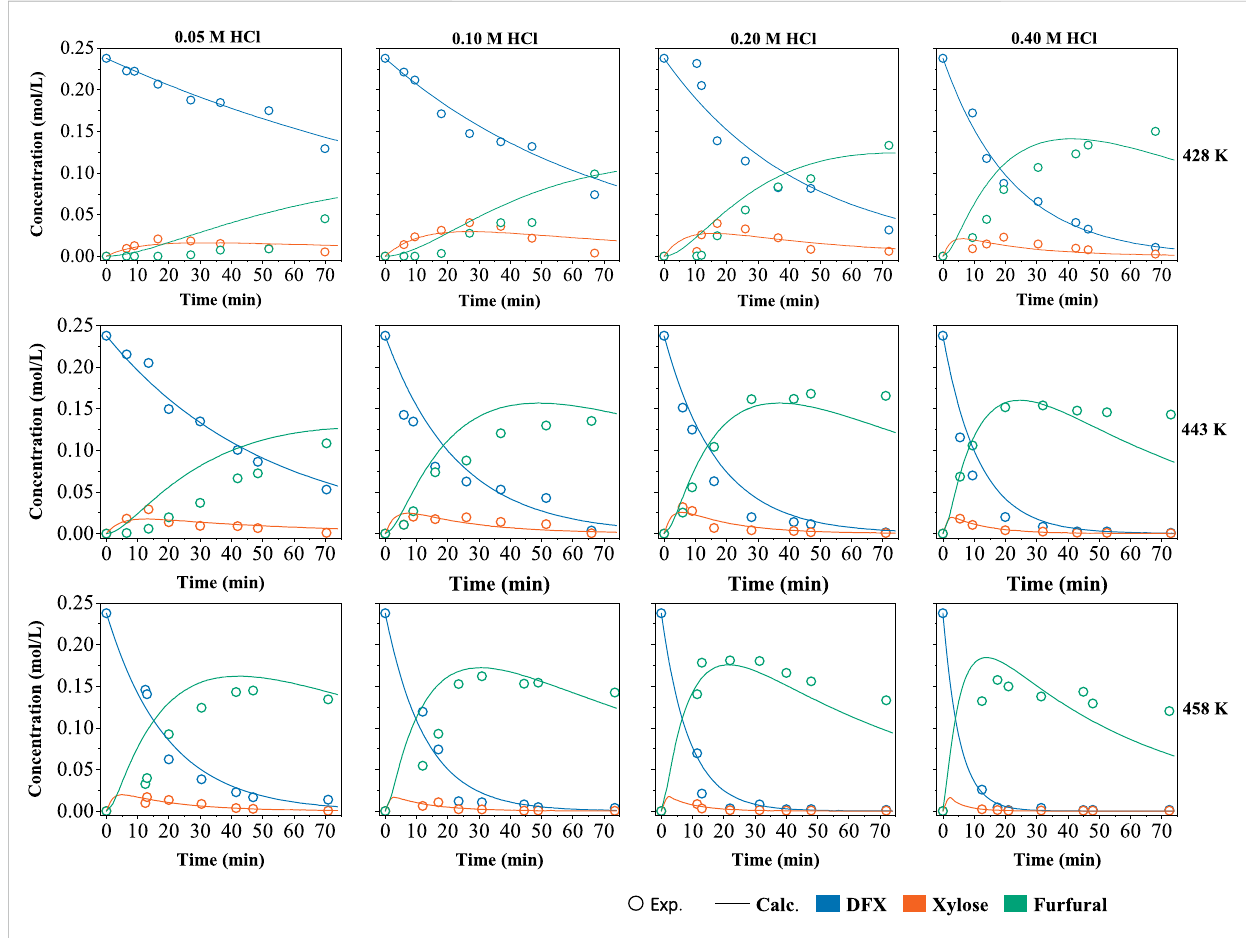
FIGURE 4 Measured concentrations of DFX, xylose and furfural in W-MIBK system and their kinetically predicted plots. Reaction conditions: DFX 0.5 g, 155 – 185 ° C, 0 – 74 min, 2 g HCl aqueous solution and 8 g MIBK, HCl 0.05 – 0.4 M, 600 rpm.